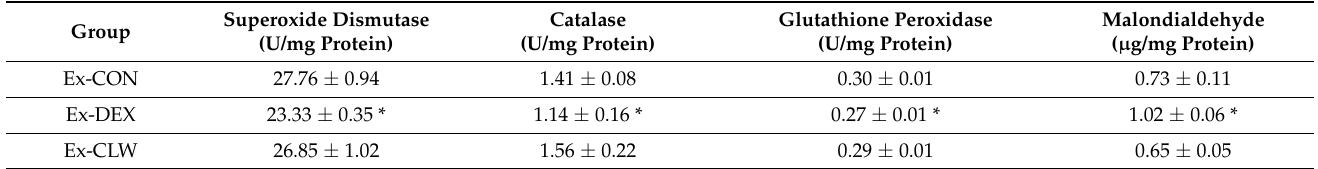
Table 1. Effect of CLW on muscular antioxidant enzyme activities and MDA